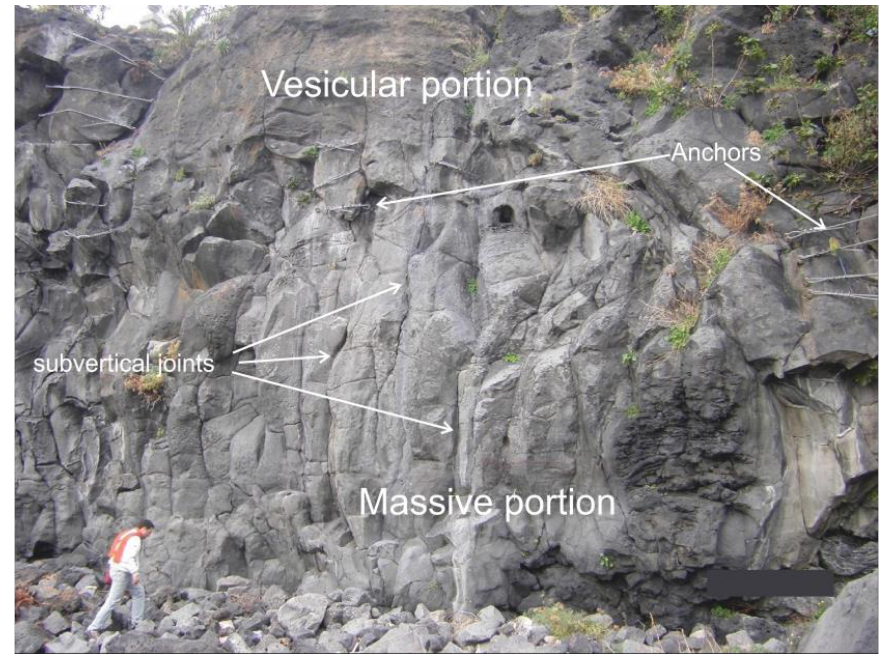
Figure 6. Rock wall surveyed for geomechanical purposes.